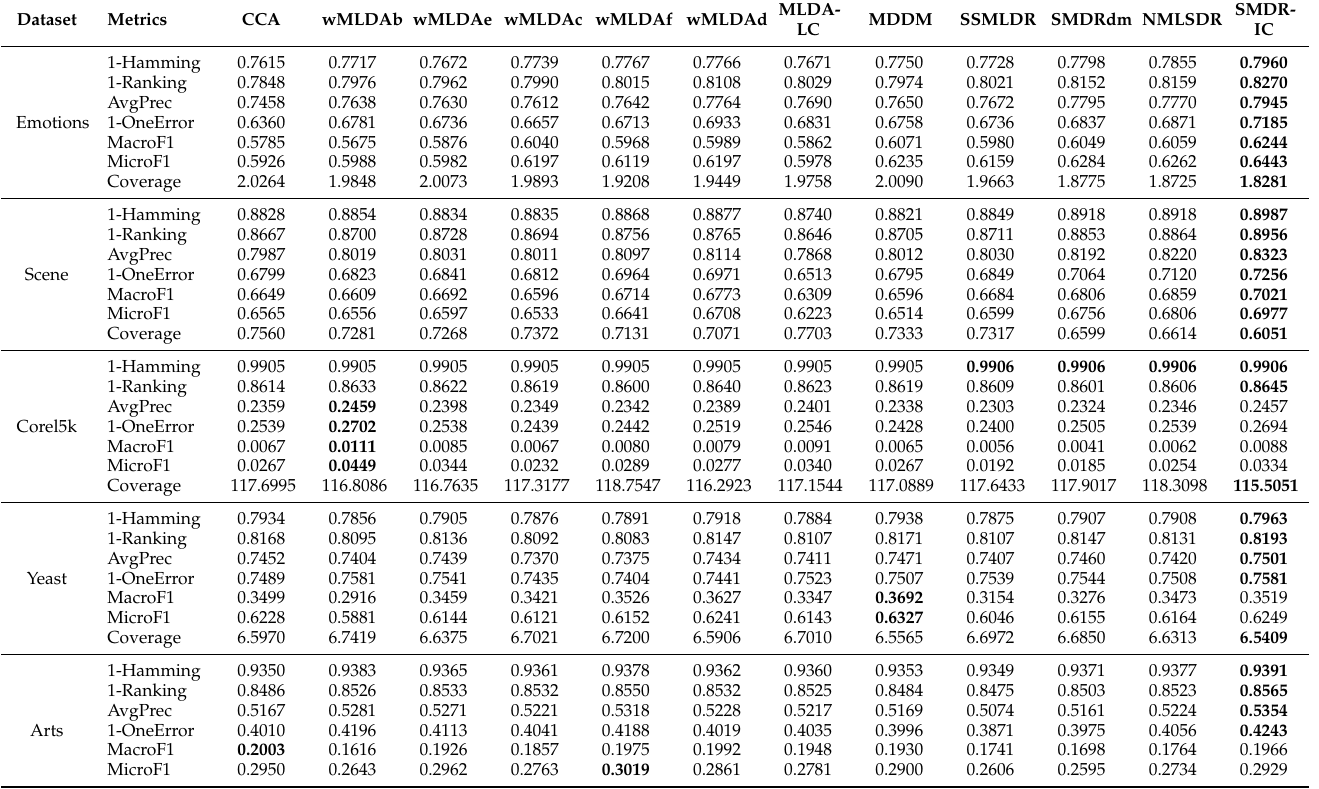
Table 4. Experimental results of 70% labeled instances on fifteen data sets in terms of seven evaluation